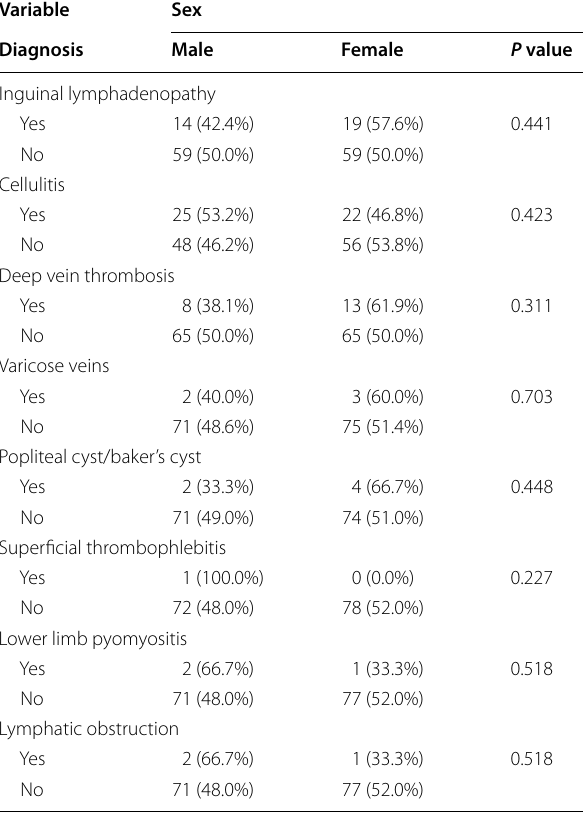
Table 6 Distribution showing the relationship between gender and ultrasound